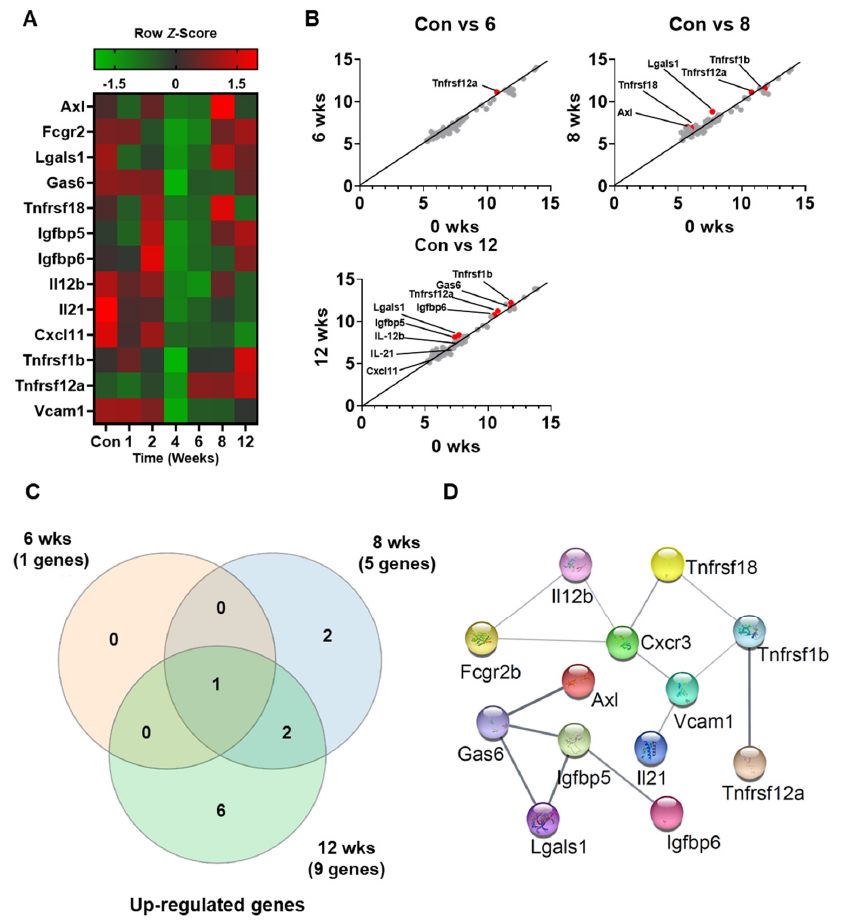
Figure 3. Secretome profiling of differentially expressed cytokines from the serum of control and HFD-fed WT mice: ( A ) Representative cytokine array analysis of the expression of 13 cytokines in the serum from control and HFD-fed WT mice ( n = 5). ( B ) Scatterplot of the differentially expressed cytokines in control versus 6, 8, and 10 weeks. ( C ) Venn diagram displaying the number of different proteins among the three groups. ( D ) STRING gene networks of interactions of increased cytokines during HFD.